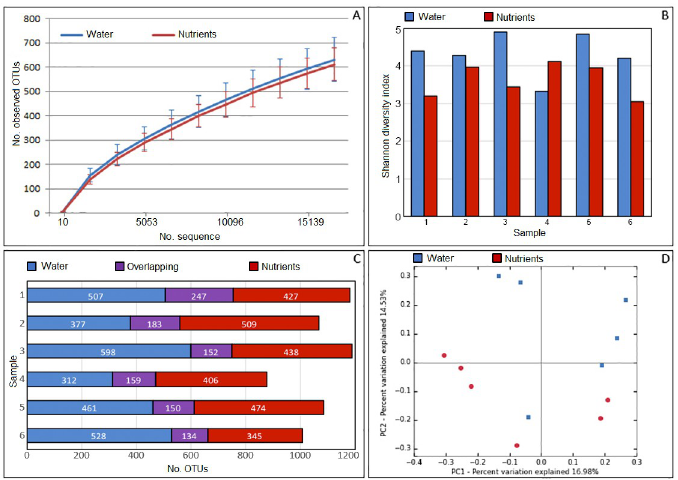
Fig 2. The dataset and diversity indices of metagenomic sequences. (A) Rarefaction curves of observed OTUs for the control and nutrient-treated groups, (B) Shannon diversity index comparison between the two treatments, (C) The number of unique and shared OTUs between the two treatments, (D) The principal coordinate analysis (PCoA) plot showing differences in bacterial community between the control and the nutrient-treated groups.